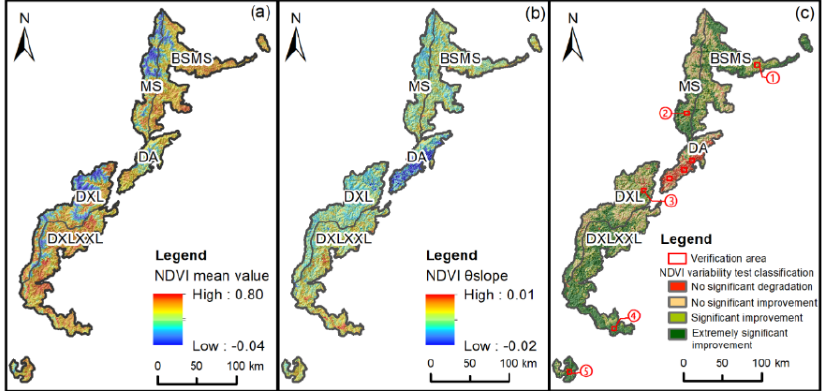
Figure 5. Annual average value of NDVI and its change from 2000 to 2020; ( a ) NDVI average value; ( b ) NDVI θ slope ; ( c ) NDVI trends.